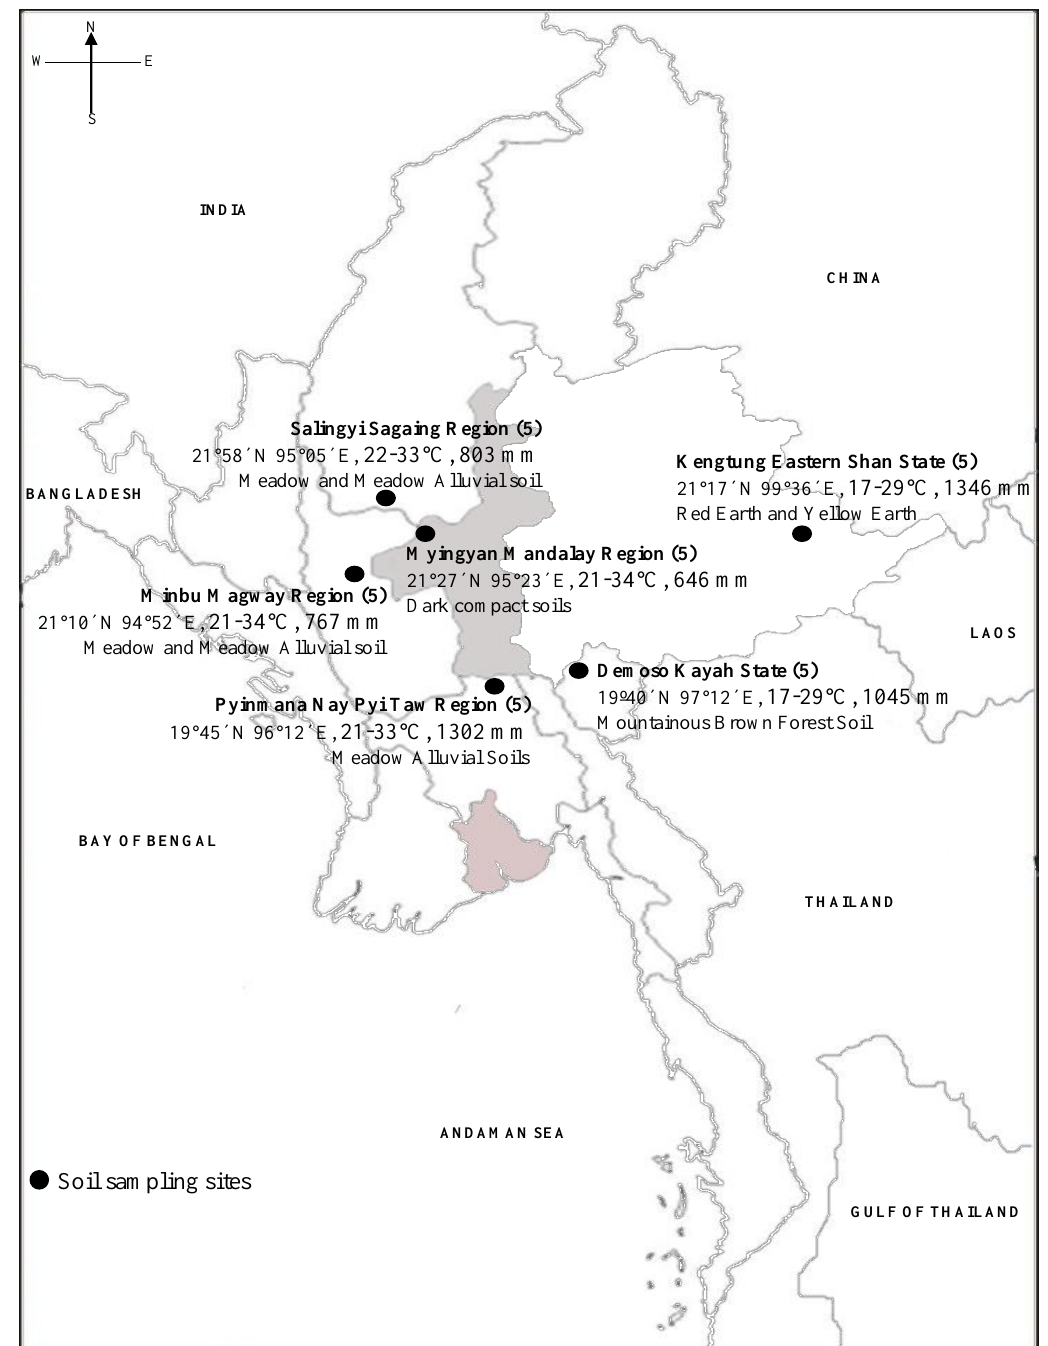
Figure1. Map of Myanmar showing soil sampling sites from chickpea major growing areas in Myanmar. Numbers in parentheses represent the total number of isolates collected from each sites.